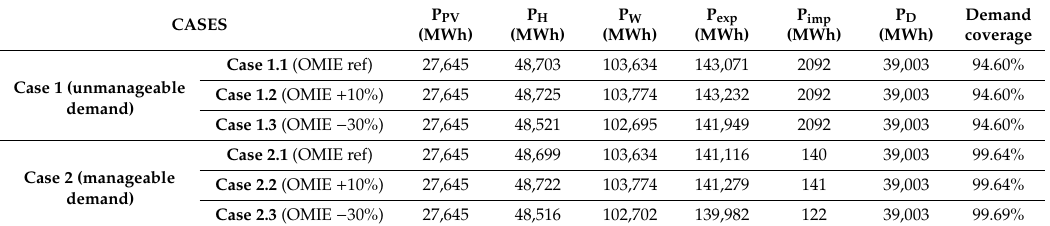
Table 9. Annual results of power generation, export and import of all cases